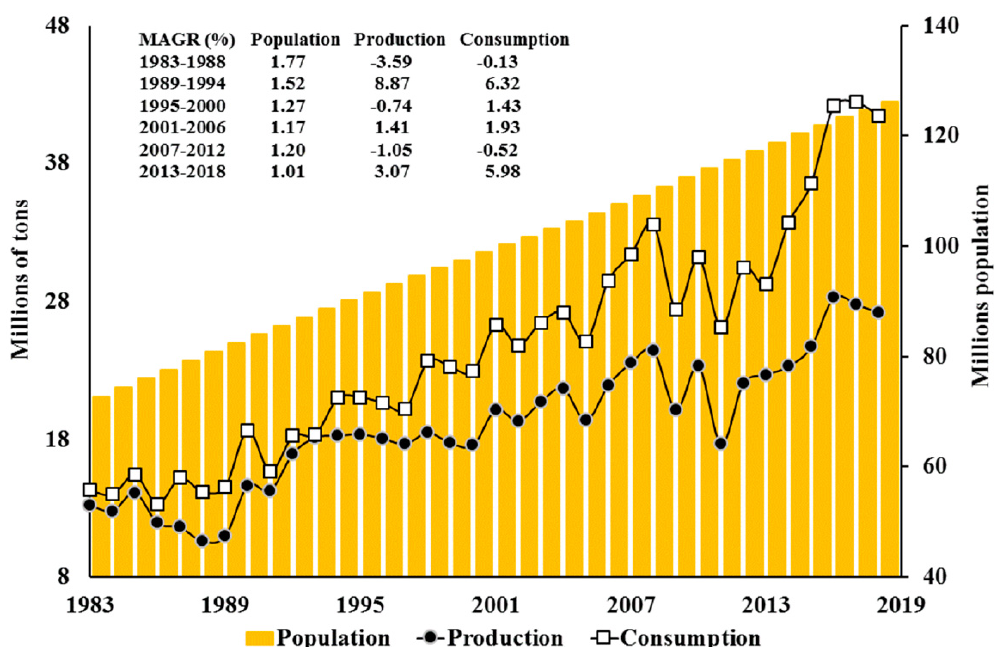
Figure 1. Temporal evolution of the Mexican population and its relationship with the production and consumption of maize from 1983 to 2018 (MAGR, Mean Annual Growth Rate).